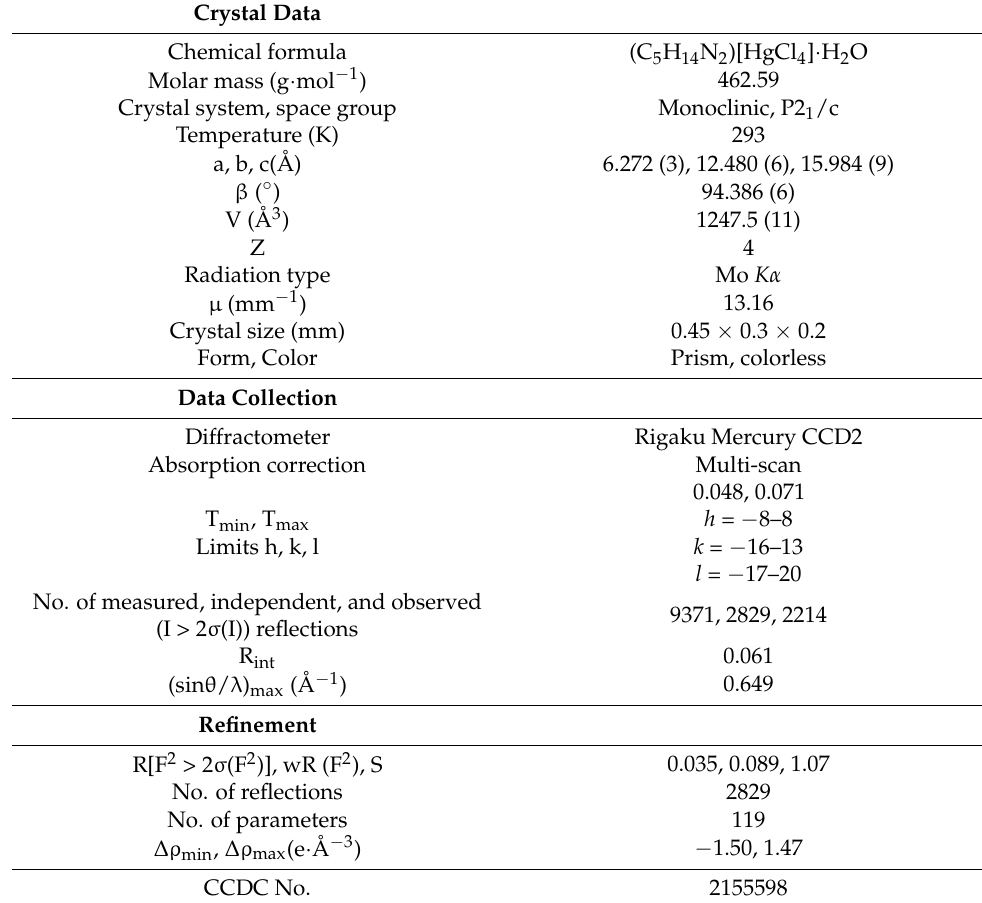
Table 1. The results obtained by the X-ray diffraction analysis on a single